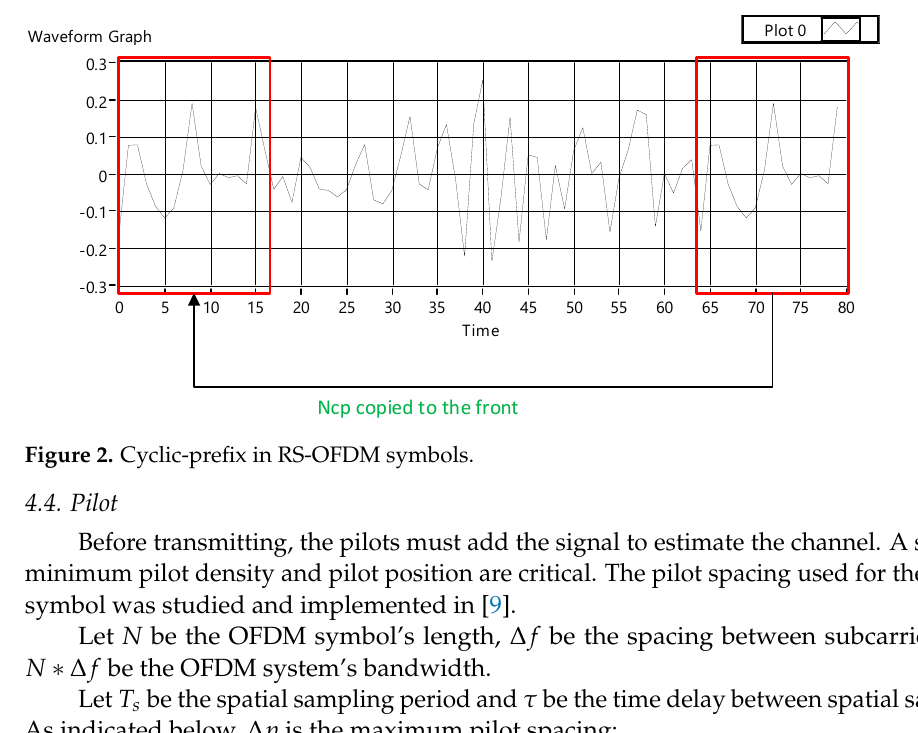
Figure 1. System Architecture .